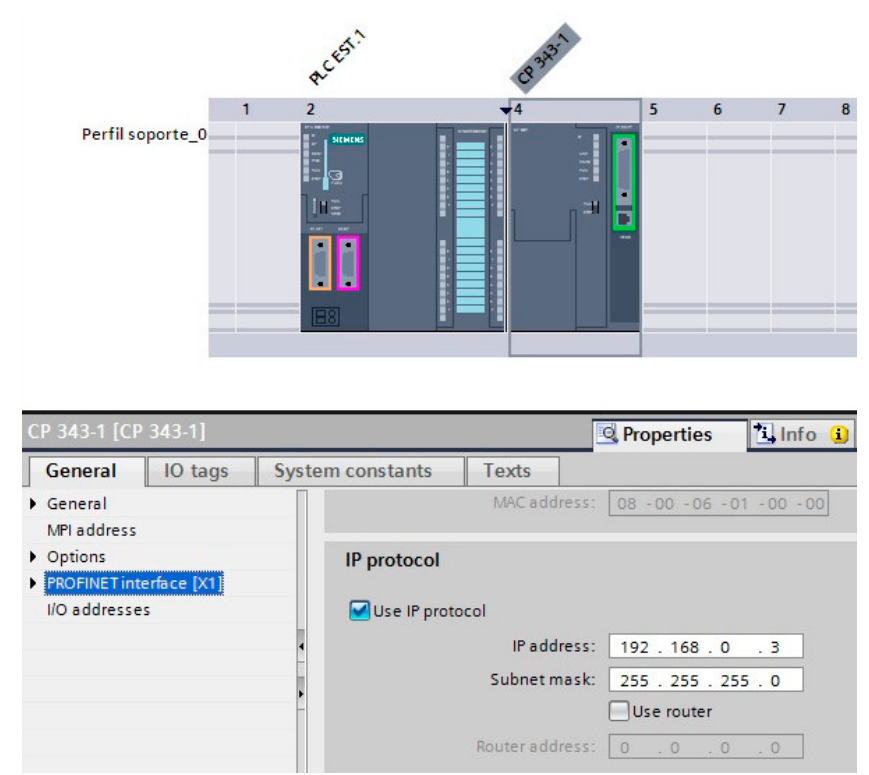
Figure 14. Configuration menu to define the CP IP address.